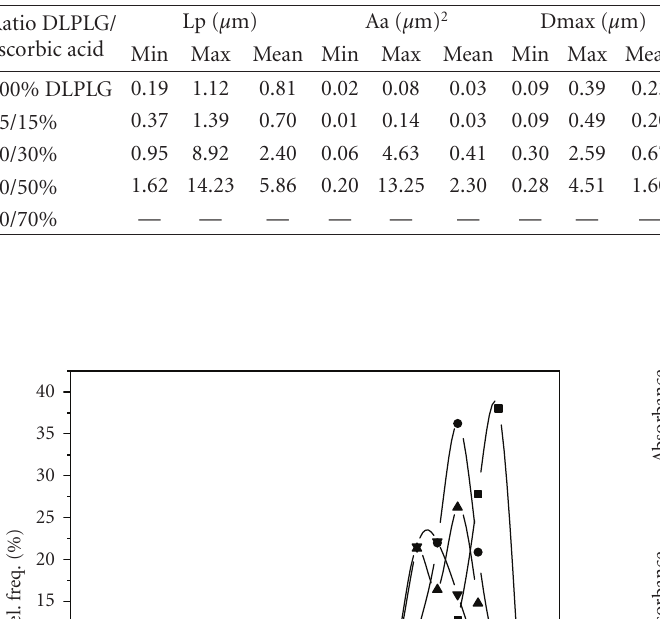
Table 1: Results of the stereological analysis of DLPLG and DLPLG/ascorbic acid particles.